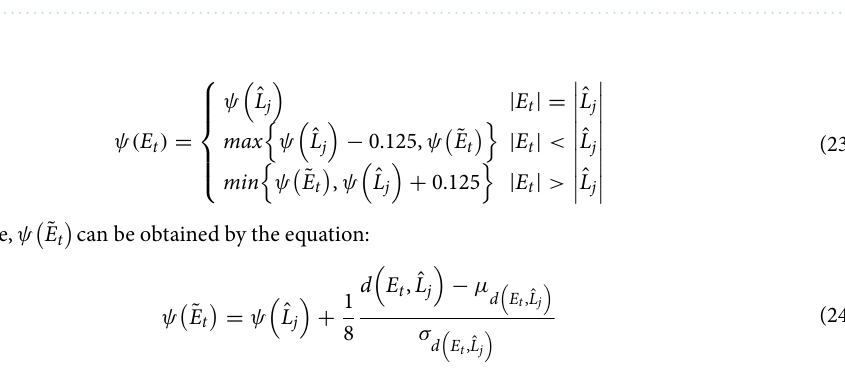
Table 2. Datasets and their levels of complexity (unit: